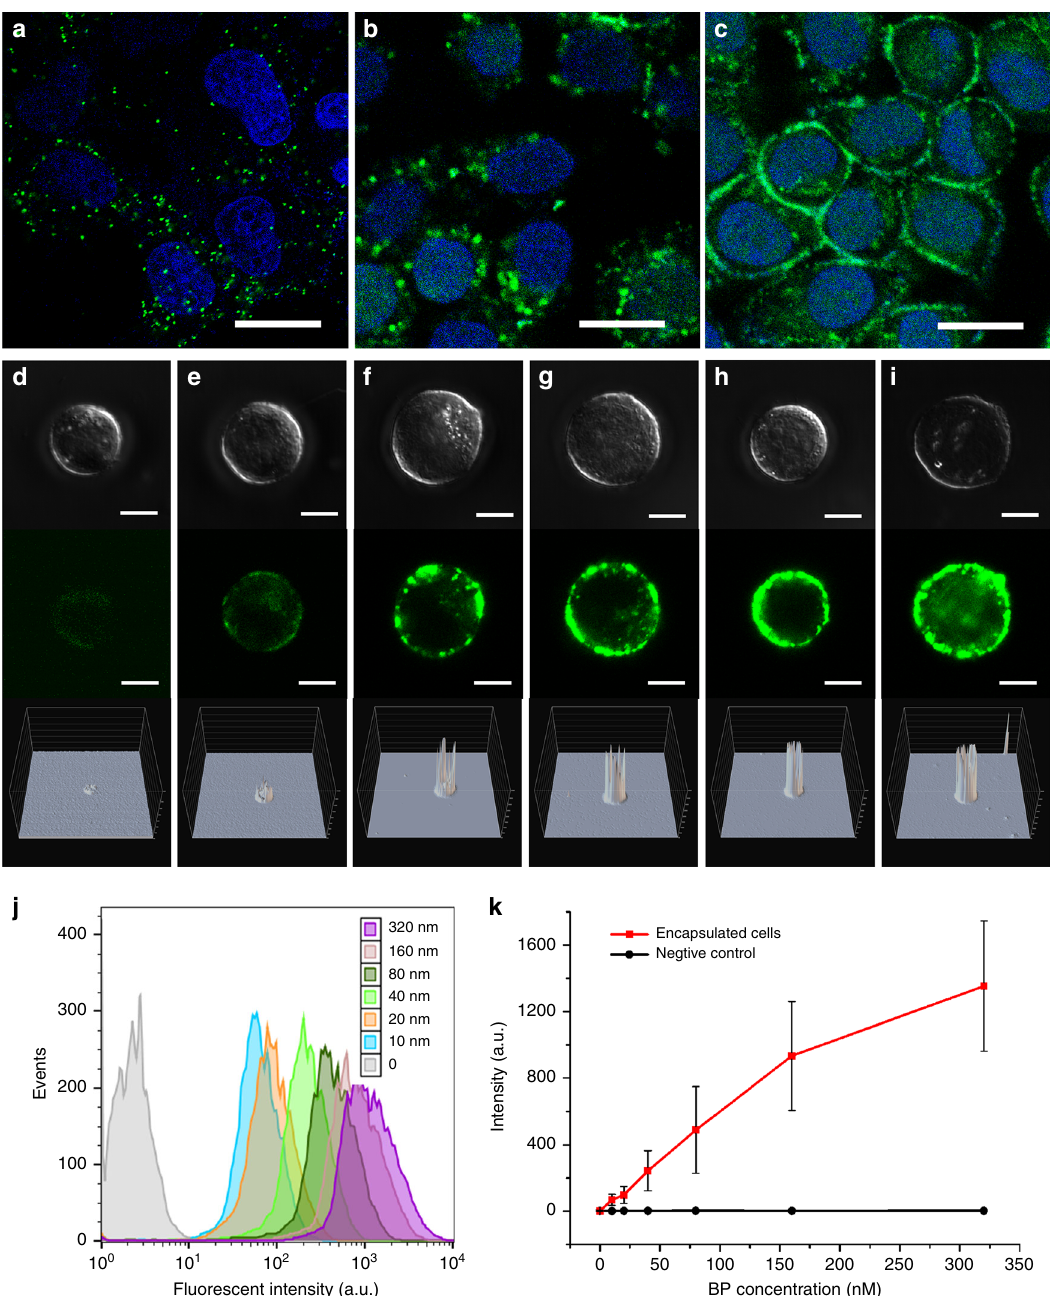
Fig. 3 Fabrication of DNA cocoons on cells. a − c Confocal fl uorescence microscopy images show the grafted DNA polymers on MCF-7 cells. The in fl uence of the R1 and R2 reactions are investigated at low concentration of 10 nM IP, where image ( a ) shows the solely conducted R1, and image ( b ) shows the coupled R1R2 reactions. Image ( c ) shows the R1R2 reactions when the IP concentration is 150 nM. The cell-surface-grafted DNA polymers are imaged after labeling with FAM-modi fi ed oligonucleotides (green). Attached MCF-7 cells are used for the fl uorescent observation in the culture dish. Scale bars, 20 μ m. d − i Differential interference contrast (DIC) and confocal fl uorescence microscopy images of the individual encapsulated MCF-7 cells, revealing the in fl uence of R2 on the formation of the DNA cocoon. The concentrations of the BP in R2 are 10, 20, 40, 80, 160, and 320 nM. The bottom row shows the analysis of the fl uorescent intensities, indicating the gain of DNA polymers densities in the DNA cocoon. Scale bars, 10 μ m. j , k Flow cytometric evaluation of the polymer density of the DNA cocoons on the MCF-7 cells. The above BP with concentrations of 10 – 320 nM are used for the cell encapsulation with isDOP. Source data are provided as a Source Data fi le. The error bars indicate the standard deviation of 10,000 cell events at each